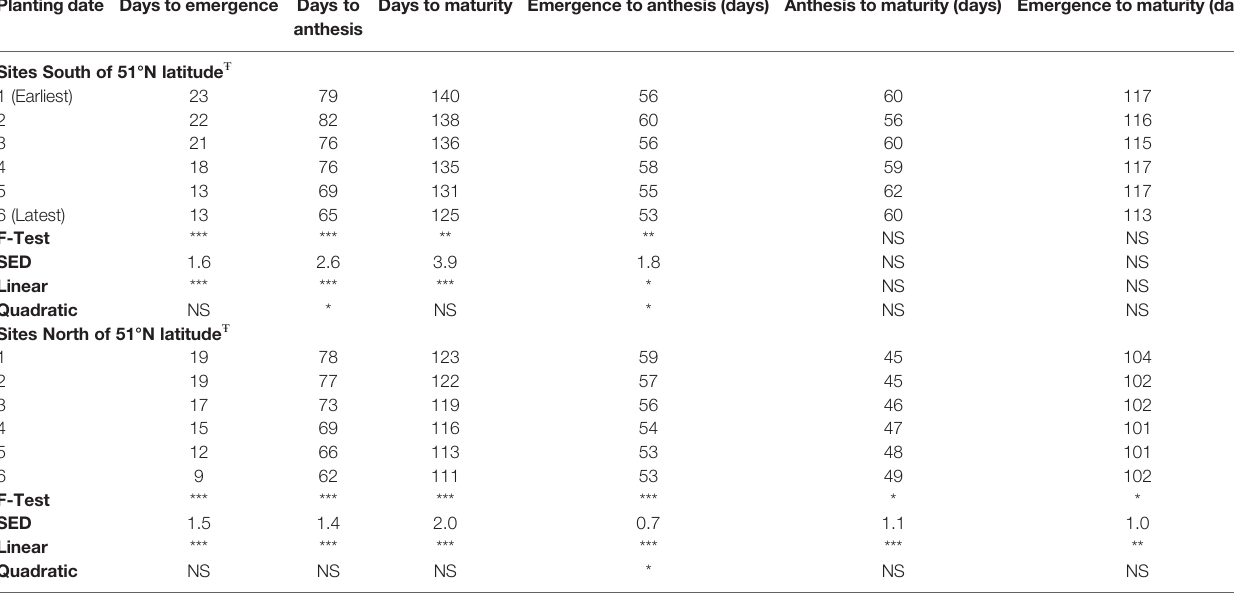
TABLE 3 | Least square means values and signi fi cance of crop development stage duration in ultra-early seeded